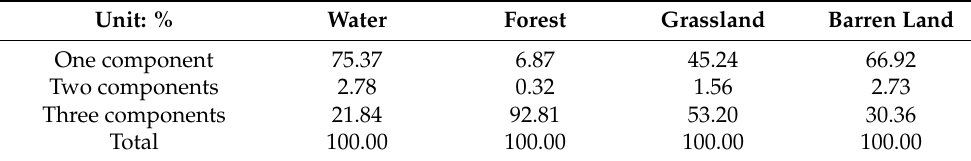
Table 2. The best sub-models for each land cover. Unit: % Water Forest Grassland Barren Land One component 75.37 Two components Three components